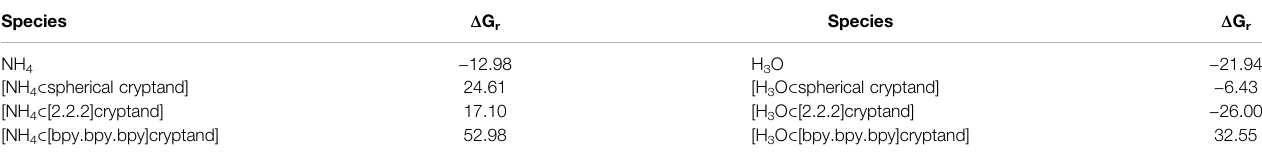
TABLE 1| Freeenergies [kcal/mol]forthedissociationreactionofhydrogenradical fromthecentral unitofinvestigated speciescalculatedat TPSSh/def2-TZVPPD//TPSSh/ def2-SVP level.